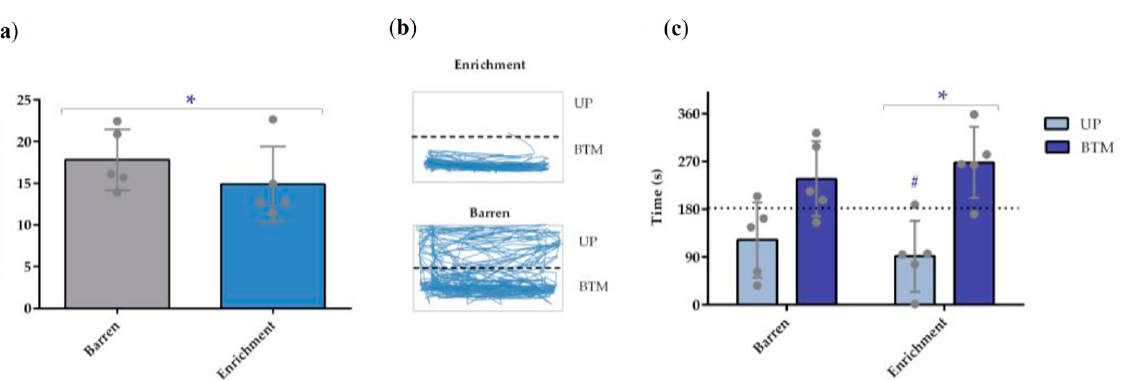
Figure 3. Time spent (s) in each side of the white/black tank by enriched and barren-housed adult zebrafish (n = 5). Data are presented as mean ± standard deviation. * p < 0.05 and *** p < 0.001 for comparisons between the white and black side of the tank for the barren and enriched-housed animals, respectively; # p < 0.05 for comparison between the time spent in the white side and the time spent there by chance (210 s). Each point represents one experimental unit, i.e., a tank.